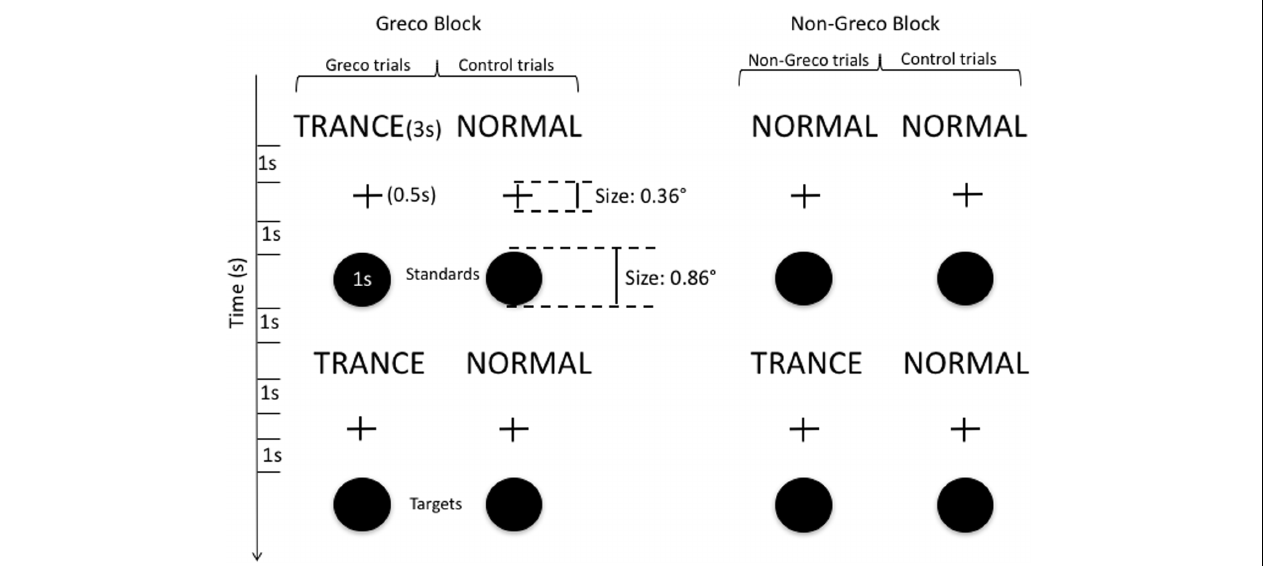
FIGURE 1 | Stimuli and delays. The figure describes the physical properties of stimuli, their duration, and the delays between them. In every trial, a first word (NORMAL or TRANCE in the Greco Block and NORMAL in the Non-Greco Block) was displayed for 3 s at the centre of the screen. After a delay of 1 s, a fixation cross was displayed at the centre of the screen for 0.5 s. One second after the disappearance of the cross, the standard disk (1 s) was displayed at the centre of the screen. One second after, the second word (TRANCE or NORMAL) was displayed. Then the fixation cross and the target disk with identical delays and durations were displayed. One second after the disappearance of the target disk, participants had to answer the duration comparison question (not shown in the figure). Once they answered the question, the word NORMAL was displayed and then participants answered successively the two subjective scales appearing on the screen after the word disappeared. Subjective scales asked participants to evaluate the depth of their “trance” [from 0 (no trance) to 5 (very deep trance)] before the first disk (first scale) and before the second disk (second disk) (not shown in the figure, see main